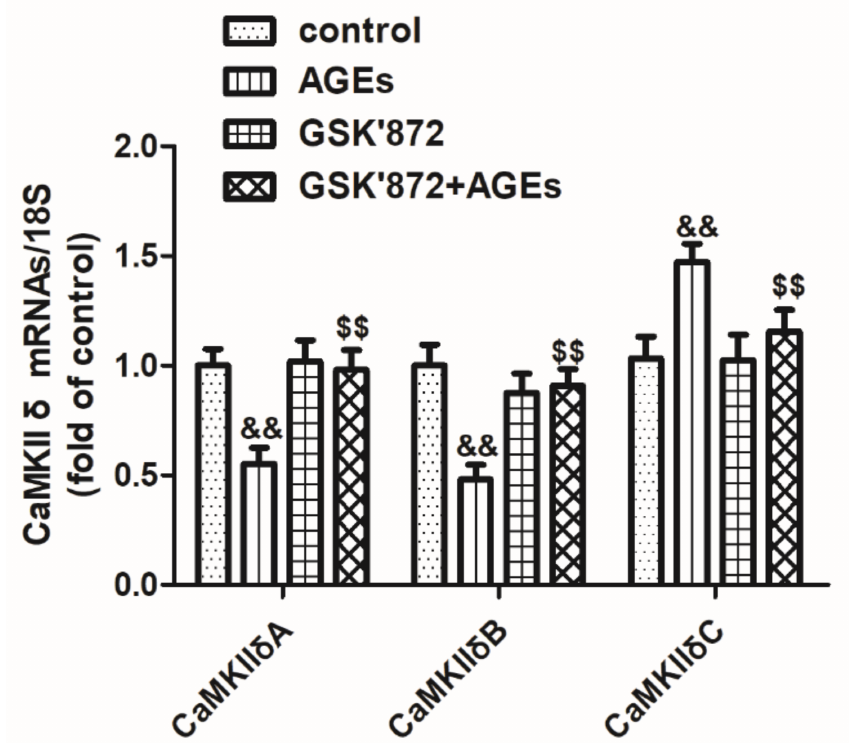
Figure 12. GSK (cid:48) 872 pretreatment ameliorated the alternative splicing disorder of CaMKII δ in cardiomyocytes. Cardiomyocytes were pretreated with 10 µ M GSK (cid:48) 872 for 4 h followed by 200 µ g/mL AGEs stimulation for 24 h. The mRNA expression of CaMKII δ A, CaMKII δ B, and CaMKII δ C was detected by quantitative real-time PCR in cardiomyocytes. 18S was used as a loading control. Plots represent the mean ± SEM; n = 6. Statistical significance: && p < 0.01 compared with control; $$ p < 0.01 compared with